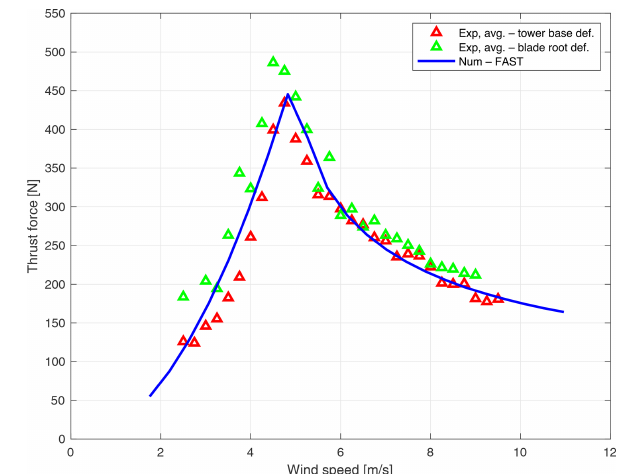
Figure 13. Comparison between the thrust curve evaluated with the two methods presented.